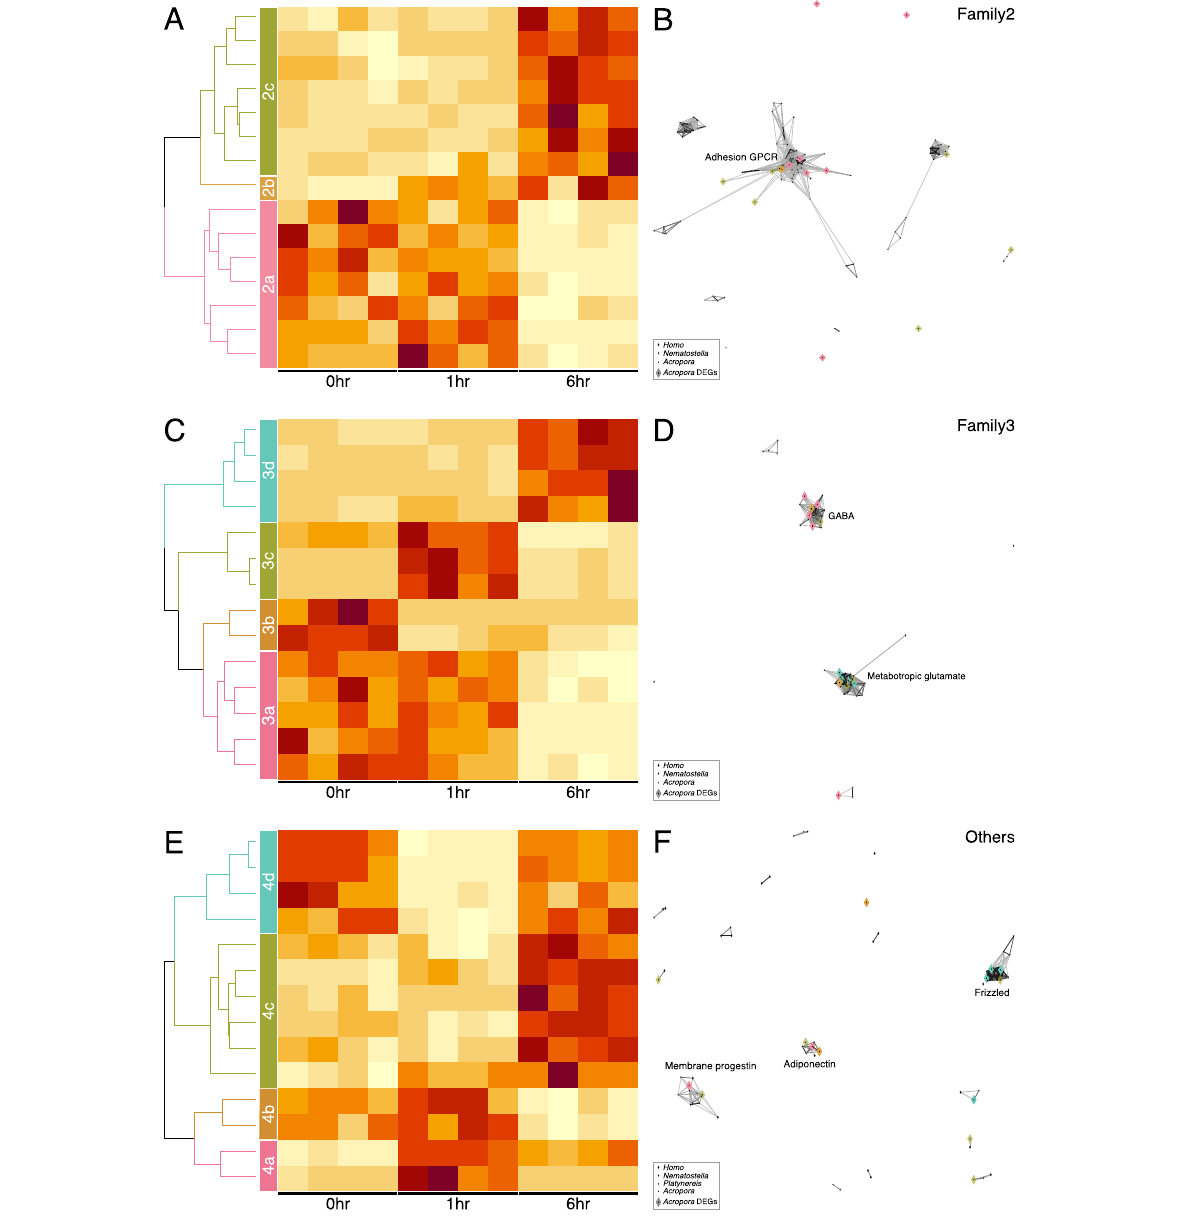
Fig. 3 DEGs in GPCR Families 2, 3, and others of Acropora tenuis . A , C , E . Heatmap of the gene expression (z score) of Families 2 ( A ), 3 ( C ), and others ( E ). The DEGs were divided into groups according to their expression patterns. B , D , F . CLANS cluster analysis of Families 2 ( B ), 3 ( D ), and others ( F ) with Homo sapiens ligand – receptor annotations. Rhombus colors correspond to the DEG groups in Families 2 ( A ), 3 ( C ), and others ( E